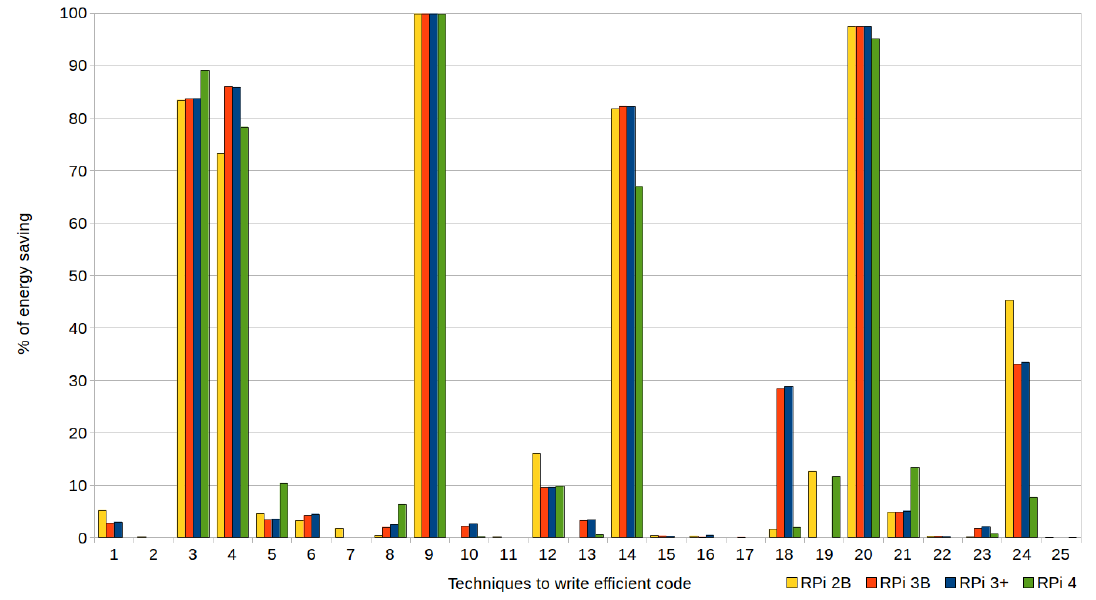
Figure 3. Percentages of energy saving achieved by writing energy-efficient code (with compiler optimization level